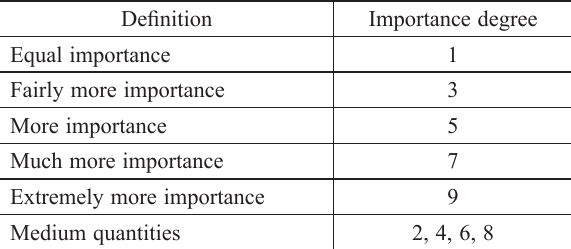
Table 1. Standard nine scale of importance degree and definition (Saati, Wind